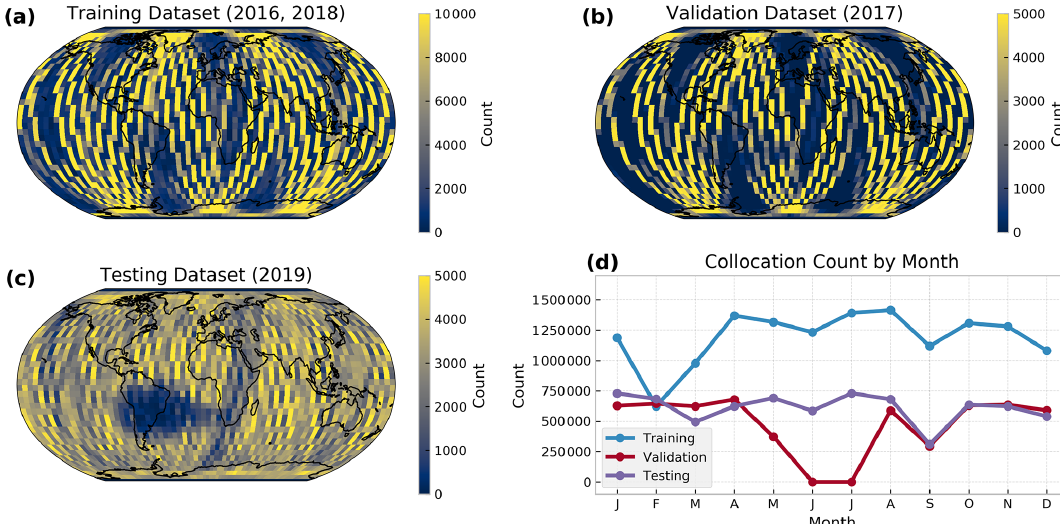
Figure 1. Spatial distribution of the unfiltered S-NPP VIIRS and CALIOP collocations for the (a) training, (b) validation, and (c) testing datasets. Panel (d) indicates the seasonal distribution of collocations for each unfiltered dataset. Note the difference in color bar limits between (a) , (b) , and (c)